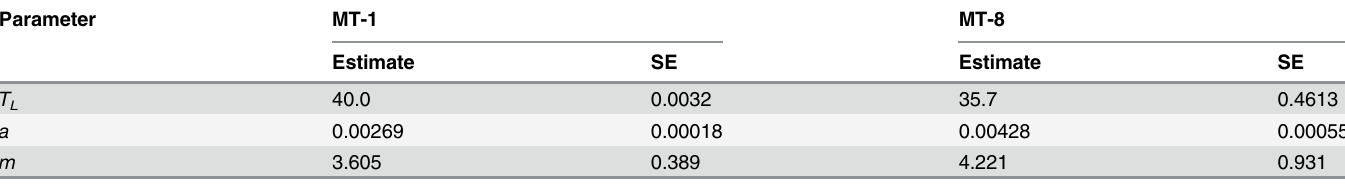
Table 1. Estimated parameters and standard errors (SE) of Briere growth curves ( a and m ) for Aceria tosichella lineages MT-1 and MT-8.